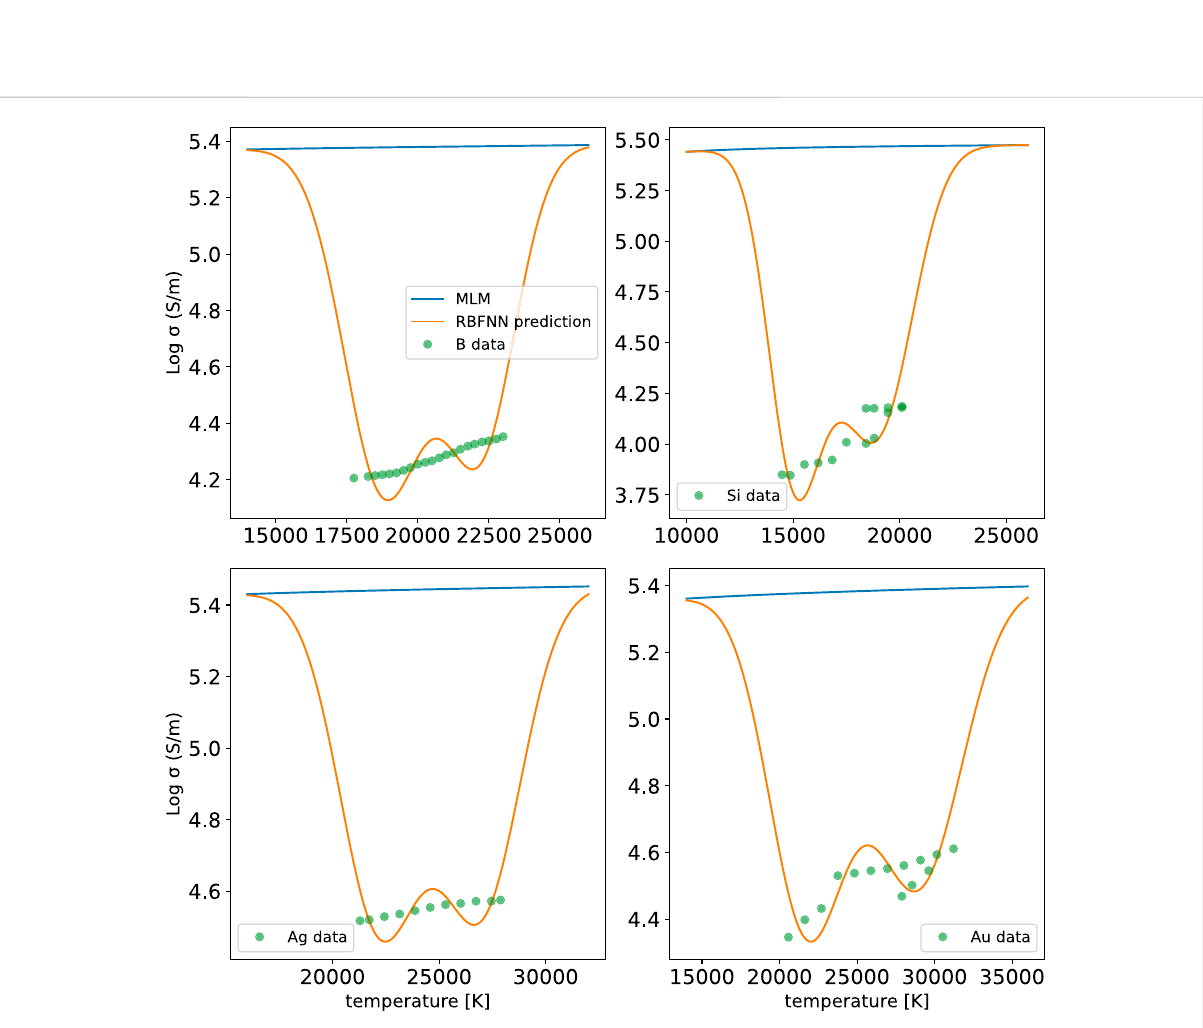
FIGURE 12 PredictionsfortheClérouin et al. dataset forfour elements. Inthiscase, conductivityisplottedversustemperaturebecausedensity didnotvary within an experiment. Three clusters were used, which limits the ability of the RBFNN to resolve what are nearly fl at